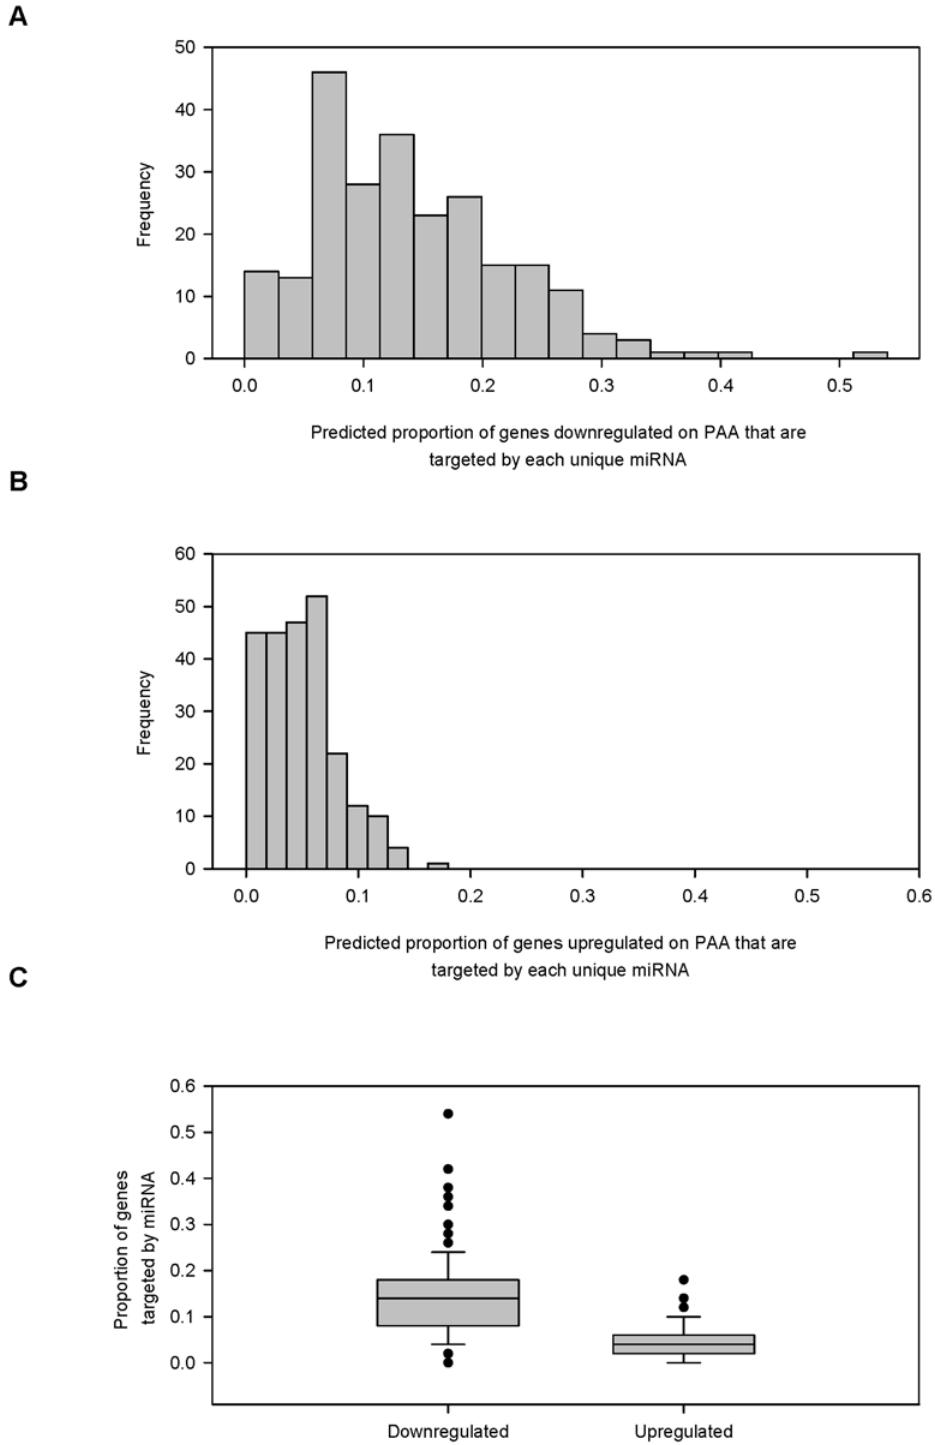
Fig 5. Downregulation of genes on PAA by specific miRNAs predicted. A random samples of 50 p robes upregulated on PAA (FC > 2) was compared to 50 probes highly downregulated on PAA (FC < -10). MicroRNA target sites were predicted from the 3' UTR o f each probe for each set using the microRNA.org. Histograms of the proportion of genes predicted to be targeted by each miRNA was created for the set of genes (A) downregulated and (B) upregulated on PAA. (C) Box plot that compared the distribution of the two sets of